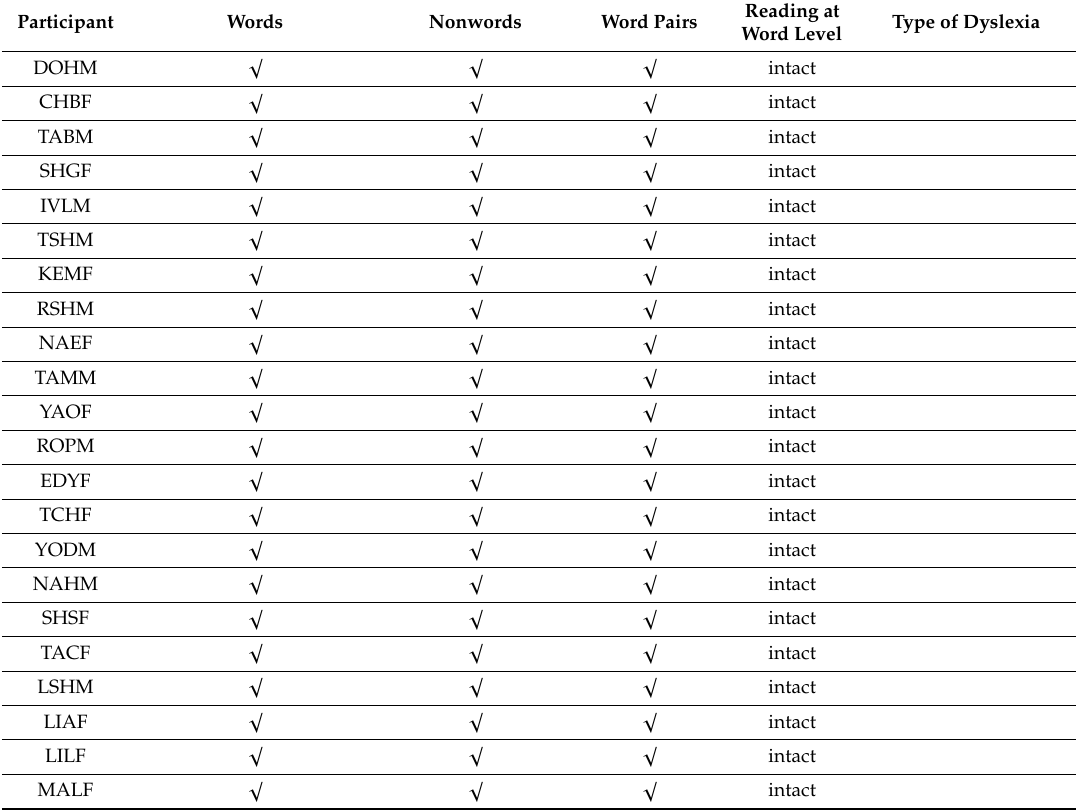
Table A2. Reading performance in the three parts of the TILTAN reading screening test. age-appropriate performance that did not di ff er from the hearing controls. When performance was significantly below the hearing controls, the cell includes % errors and main error